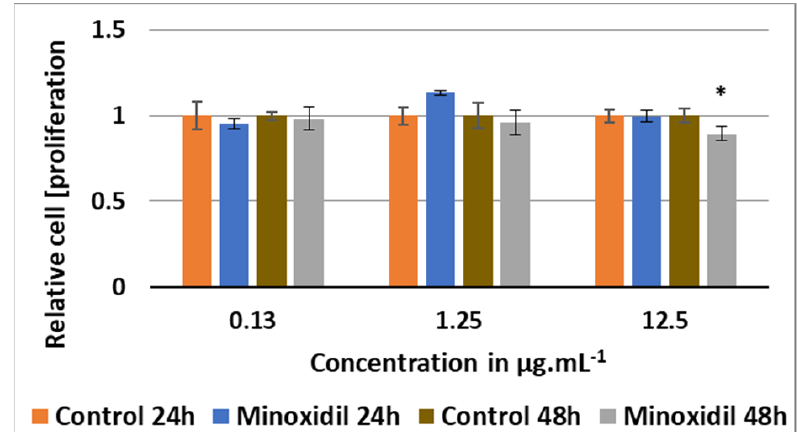
Figure 4. Cell-proliferating effect of minoxidil after 24 h and 48 h of treatment of dermal papilla cells with concentrations 0.13, 1.25 and 12.5 µ g mL − 1 compared the control. Significance is determined by * p < 0.05, using a Student’s t -test.